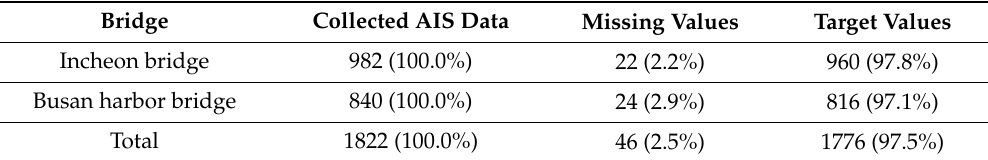
Table 3. Result of missing values treatment according to data